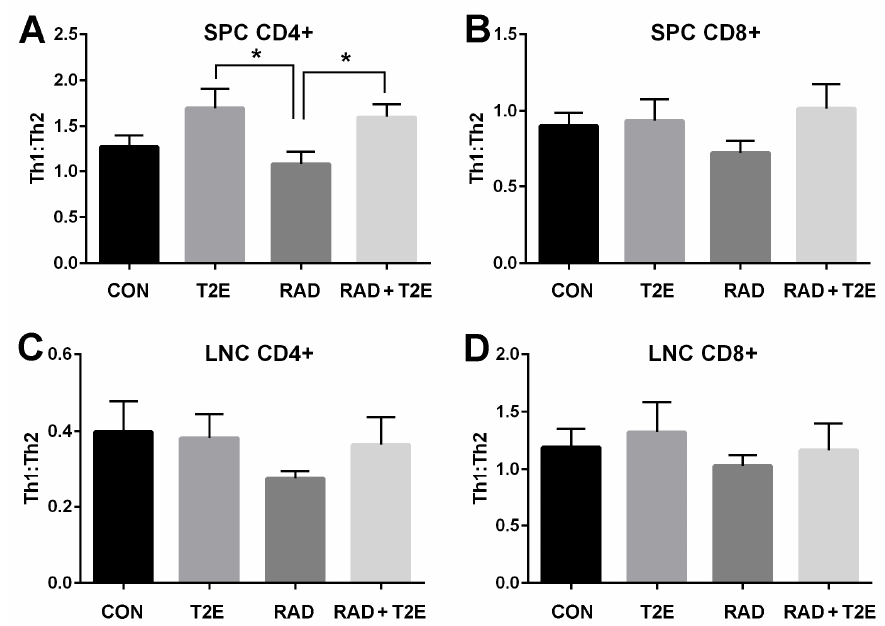
Figure 6. MnTE-2-PyP enhances Th1:Th2 ratio in CD4+ splenocytes 2 months post-irradiation. Splenocytes and lymphocytes were obtained from mice treated with +/ − MnTE-2-PyP and +/ − radiation, at 2 months post-radiation. These cells were stimulated to enhance cytokine production and then immunolabelled for CD4, CD8, IFN γ (Th1) and IL-4 (Th2). The ratio of Th1: Th2 were calculated for cell type. ( A ). Th1:Th2 in CD4+ splenocytes (SPC). ( B ). Th1:Th2 in CD8 + SPC. ( C ). Th1:Th2 in CD4+ lymphocytes from isolated lymph nodes (LNC). ( D ). Th1:Th2 in CD8+ lymphocytes from isolated from LNC. A 1-way ANOVA followed by post hoc Tukey’s test for multiple comparisons was used to determine differences between groups. The symbol (*) denotes a significant difference. Isolated cells were used from 9–10 animals/group.